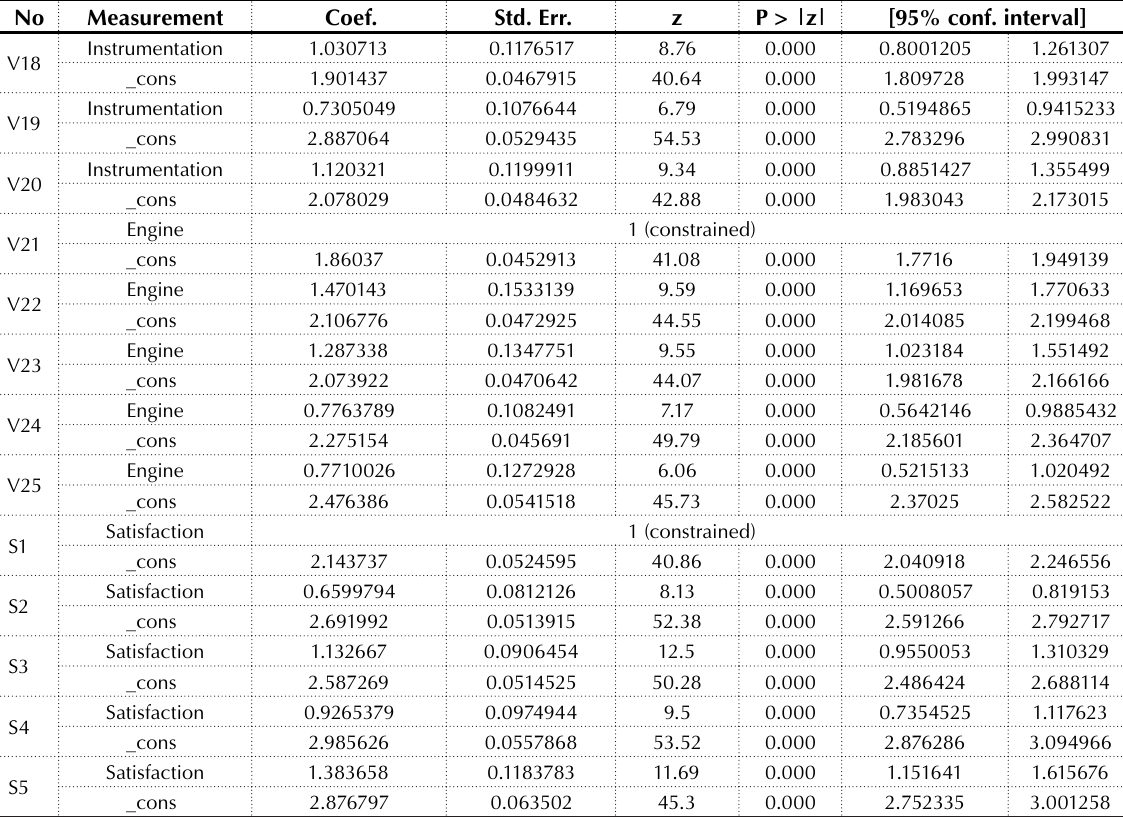
Table 5 (cont.). Output sheet from Stata (measurement) No Measurement